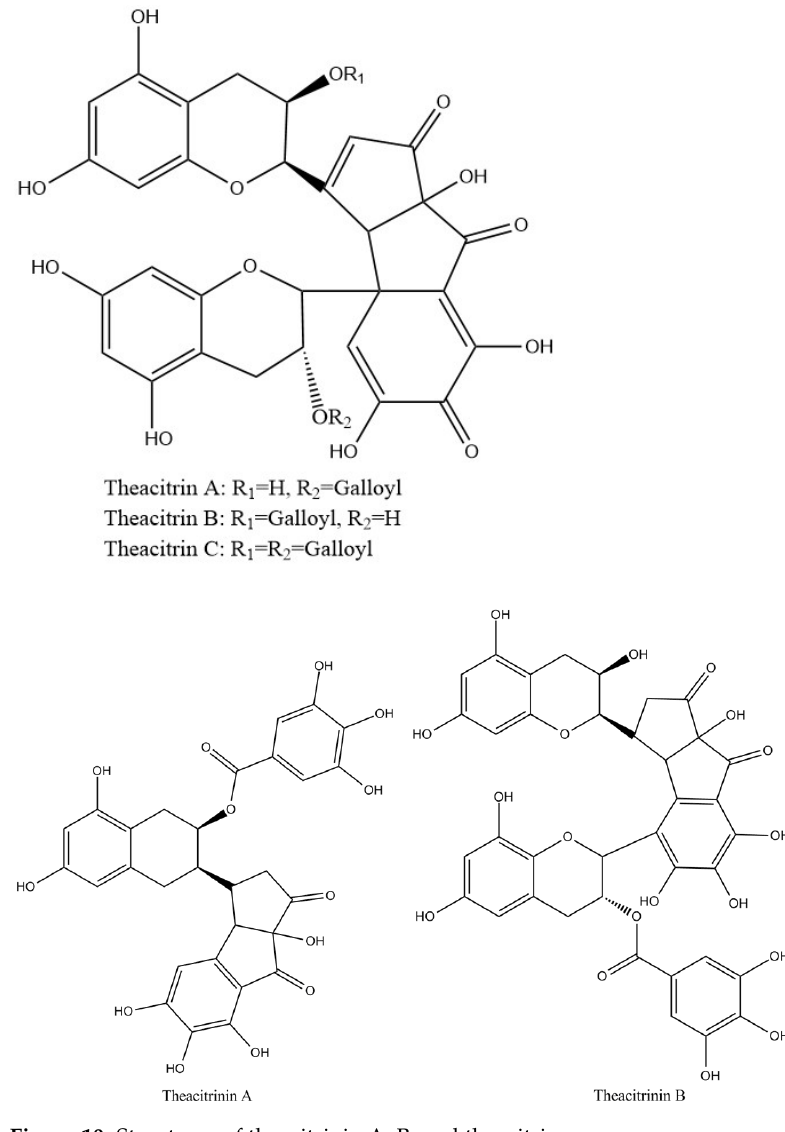
Figure 10. Structures of theacitrinin A, B, and theacitrins.